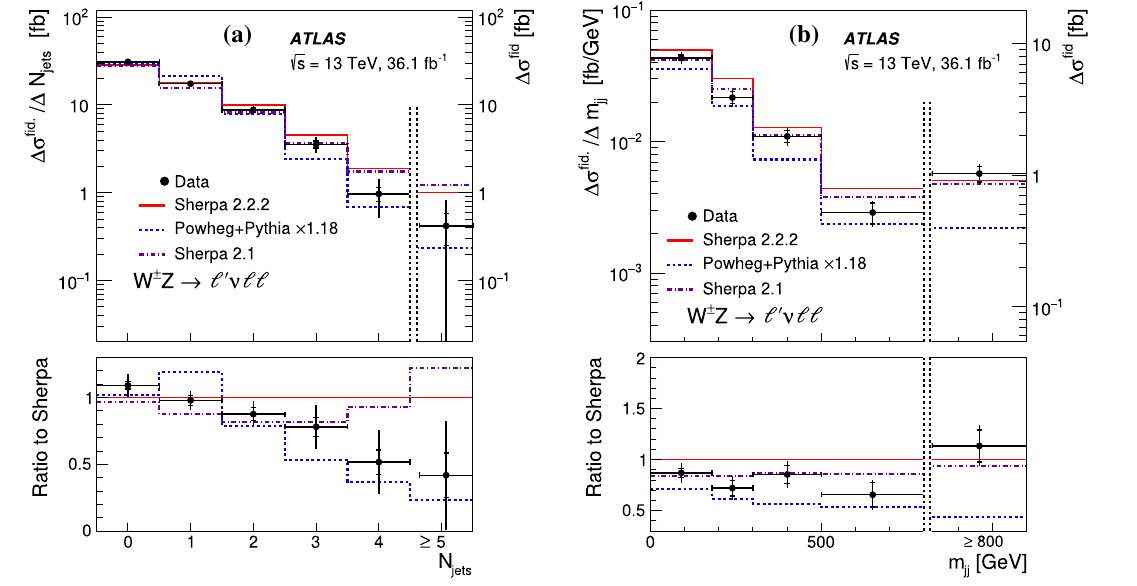
Fig. 6 The measured W ± Z differential cross section in the fiducial phase space as a function of the exclusive multiplicity of jets with p T > 25 GeV ( a ) and of the invariant mass of the two leading jets with p T > 25 GeV ( b ). The inner and outer error bars on the data points represent the statistical and total uncertainties, respectively. The measurements are compared with the predictions from Sherpa 2.2.2